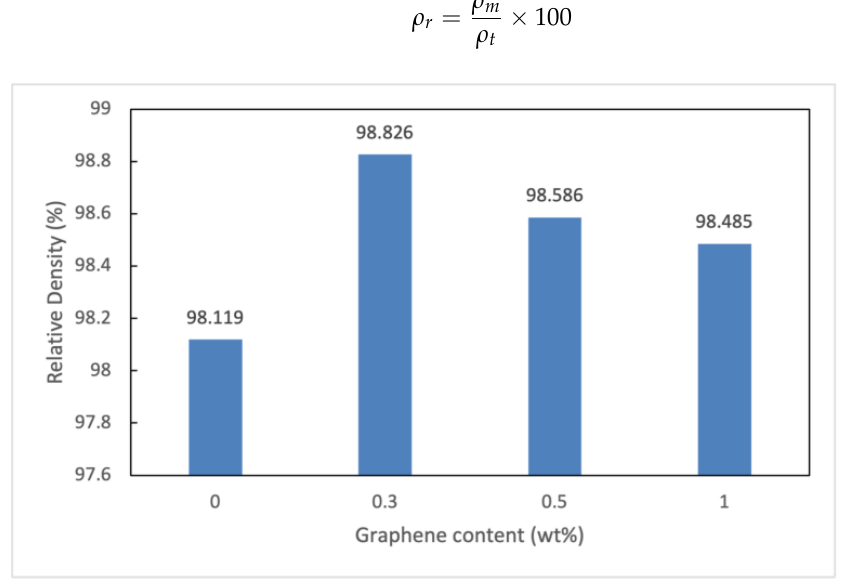
Figure 8. Relative density of thixoformed composite sample.